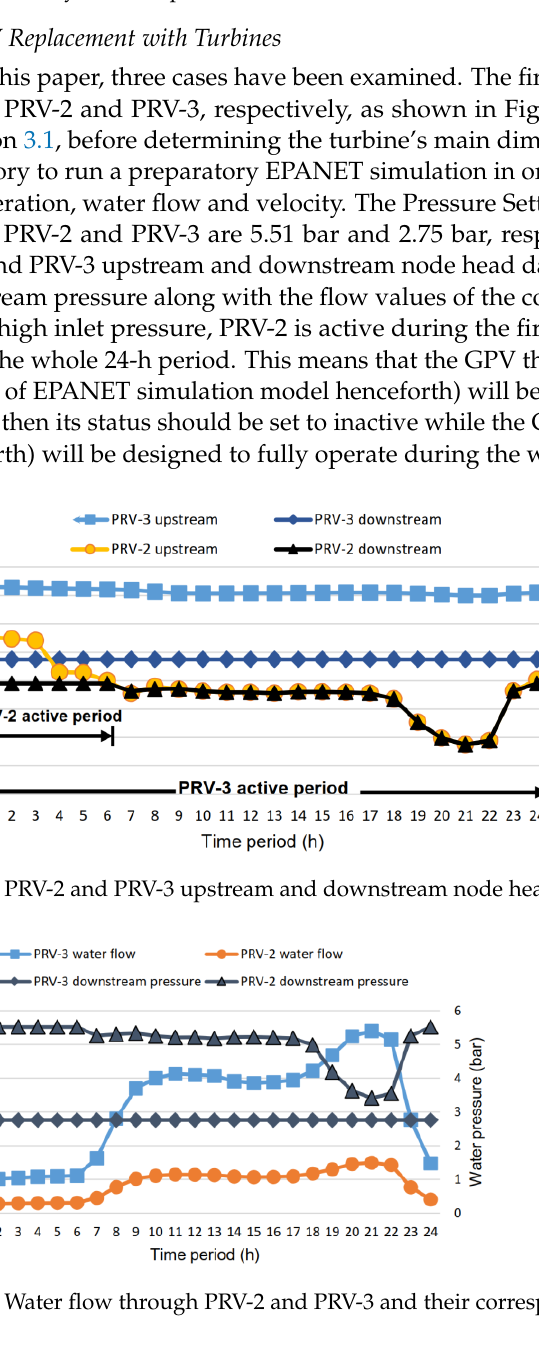
Figure 7. Hourly demand pattern of network nodes.